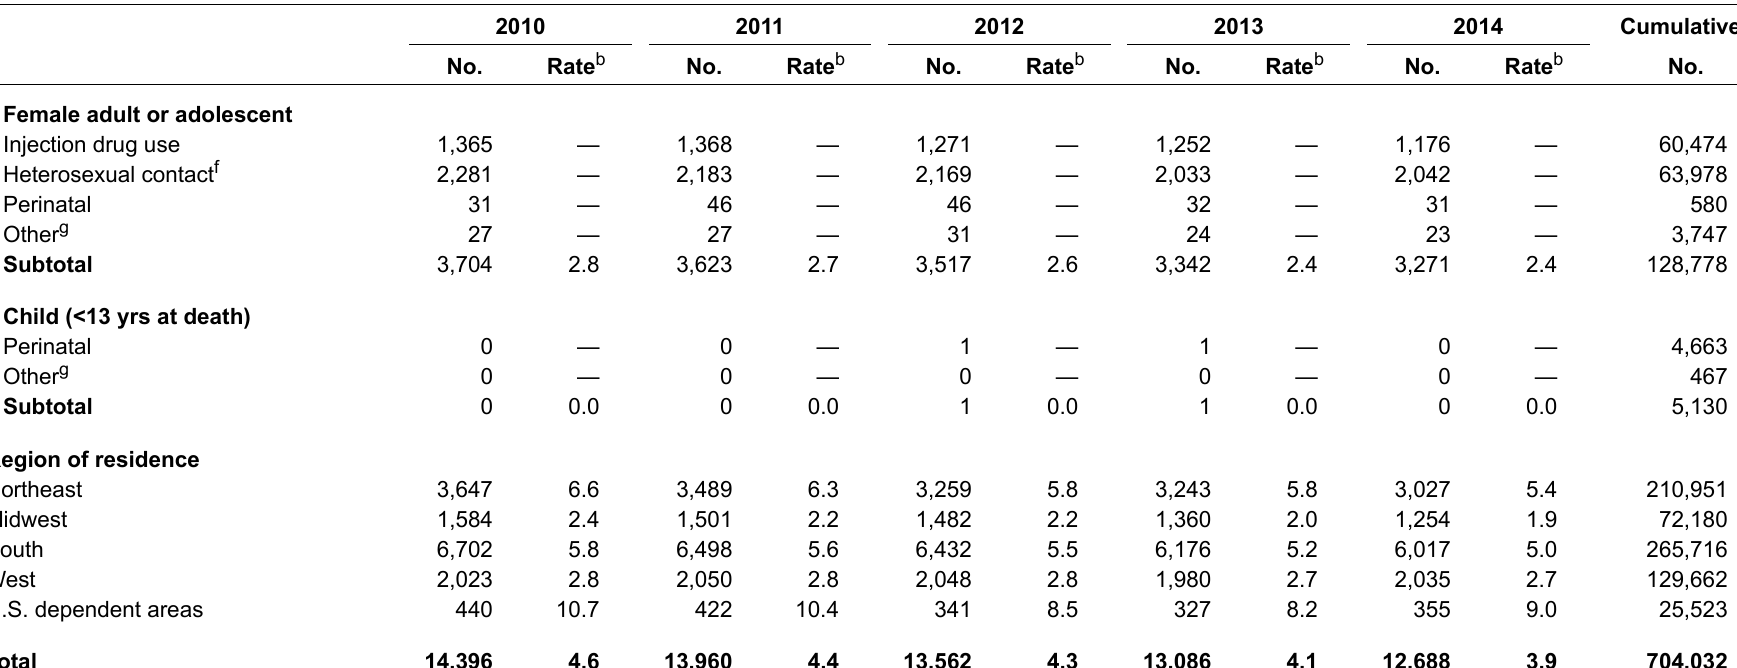
Table 13b. Deaths of persons with diagnosed HIV infection ever classified as stage 3 (AIDS), by year of death and selected characteristics, 2010–2014 and cumulative—United States and 6 dependent areas